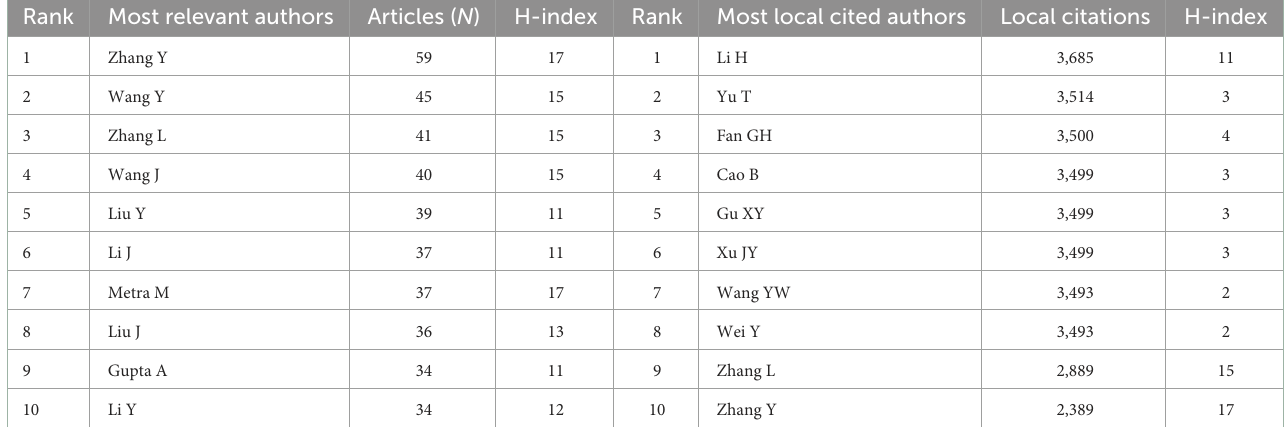
TABLE 5 Top 10 most productive authors and co-cited authors correlated with COVID-19-related CVD research. Rank Most relevant